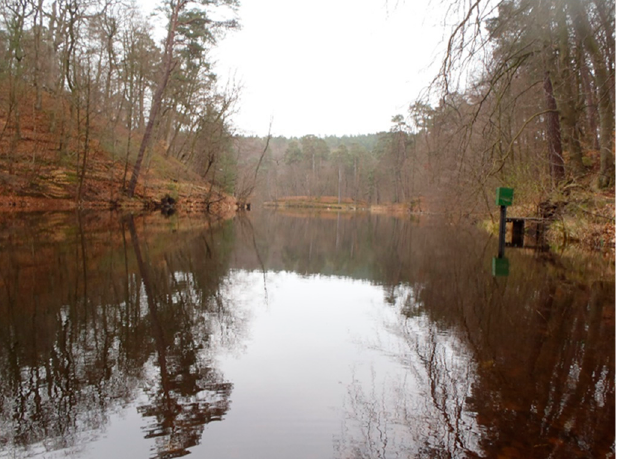
Figure 4. View over Gardno Lake from the north (photo: Konrad Wrzecionkowski).